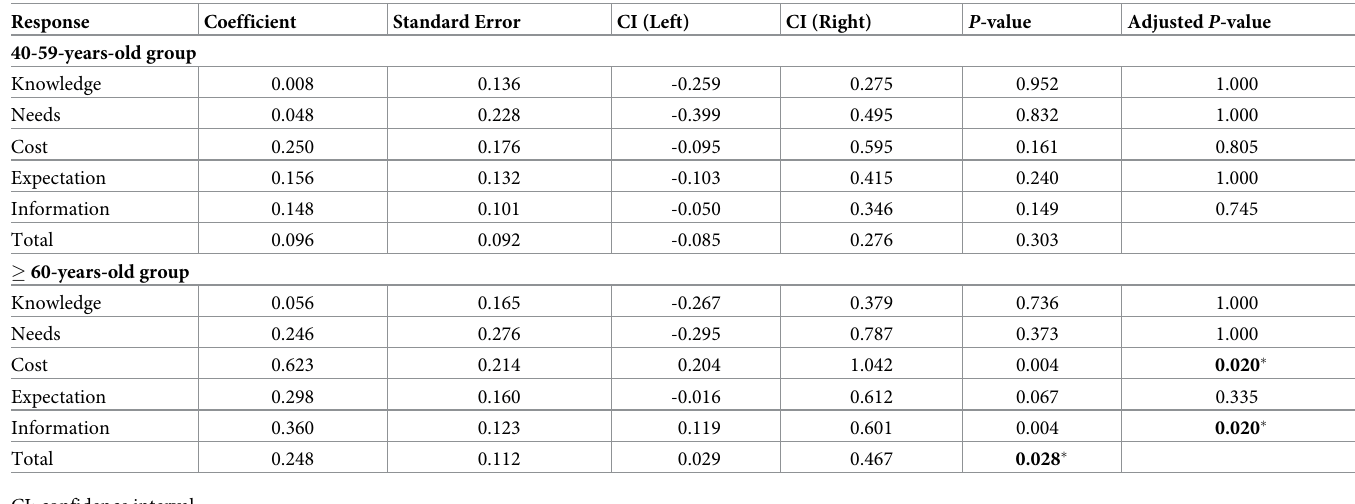
Table 2. Relationships between age and perception scores on personal sound amplification products. Reference age group was the 20-39-years-old group. Response